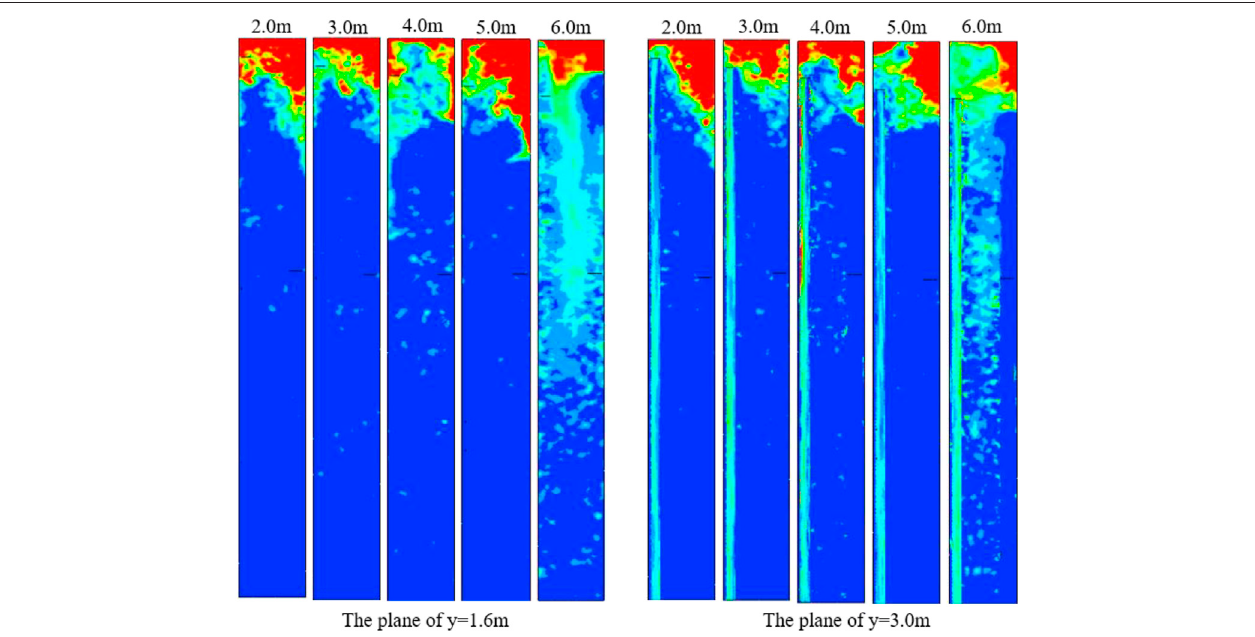
FIGURE 10 | Dust diffusion at planes of y = 1.6 and 3.0 m for different dedusting-air duct distances (no roadheader).